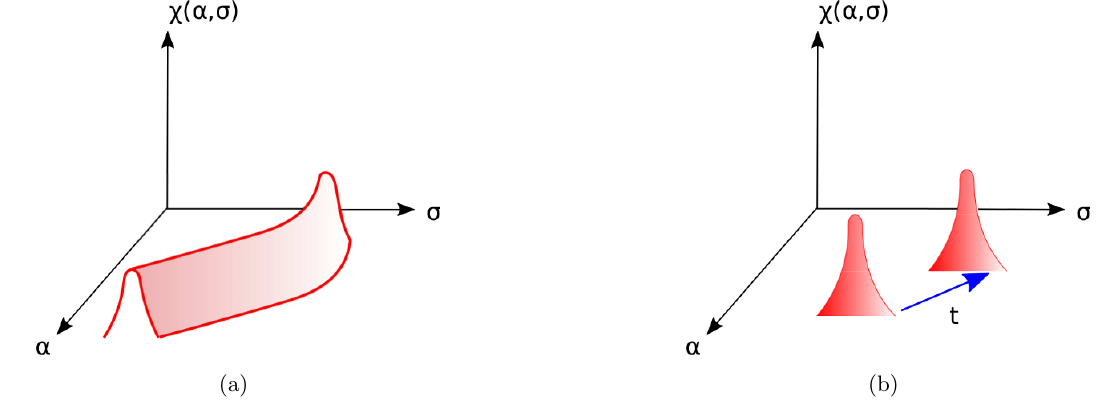
Figure 6 . (a) States that satisfy the Hamiltonian constraint are extended in the space of the collective variables, and are not normalizable. (b) Physical states with (cid:12)nite norms spontaneously break the symmetry generated by the Hamiltonian. The Goldstone mode associated with the spontaneously broken symmetry gives rise to a non-trivial time